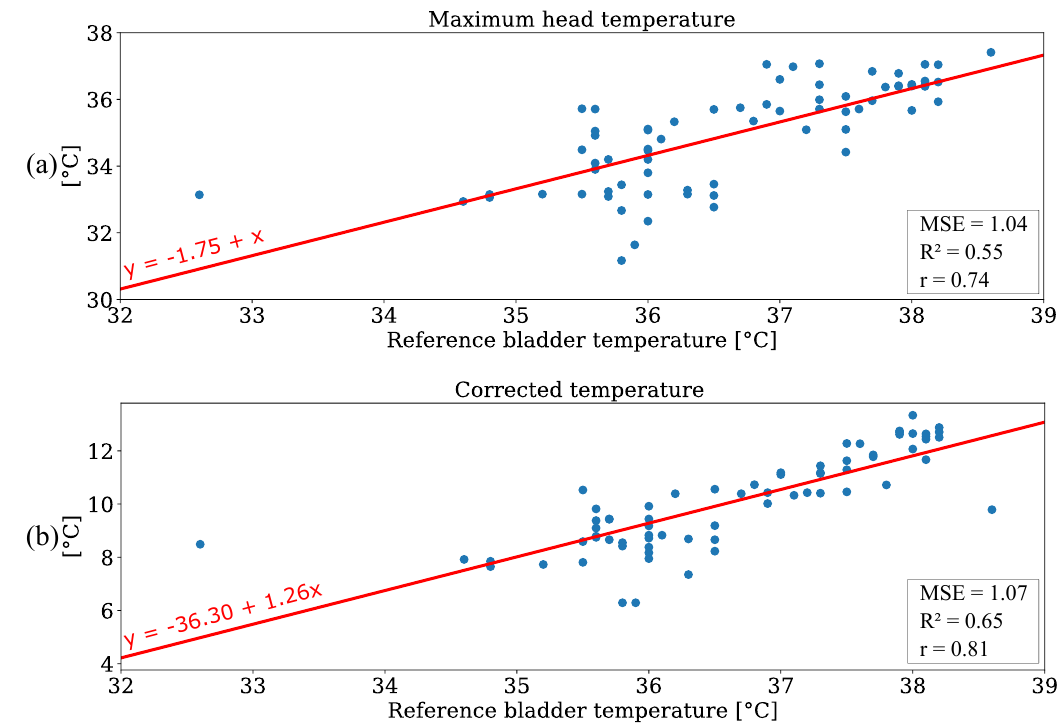
Figure 11. Regression analysis for ( a ) maximum head temperature and ( b ) corrected temperature values.